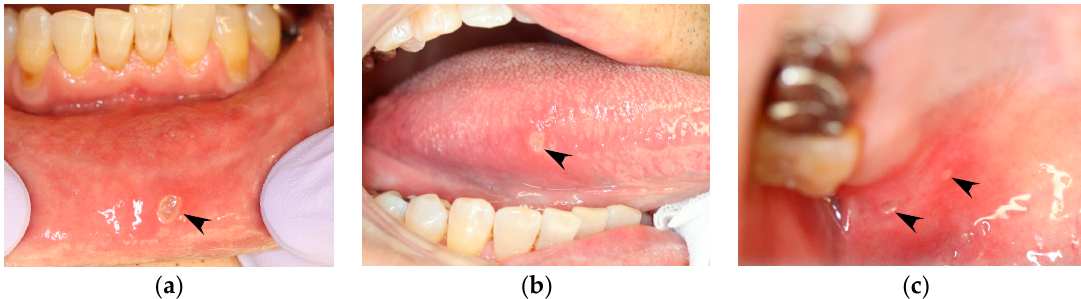
Figure 1. Aphthous stomatitis that occurs in a patient with recurrent aphthous stomatitis (RAS). Images are of the same patient and were taken on the same day. ( a ) Lower labial mucosa. ( b ) Right margin of the tongue. ( c ) Right hard palate mucosa (black arrowheads).